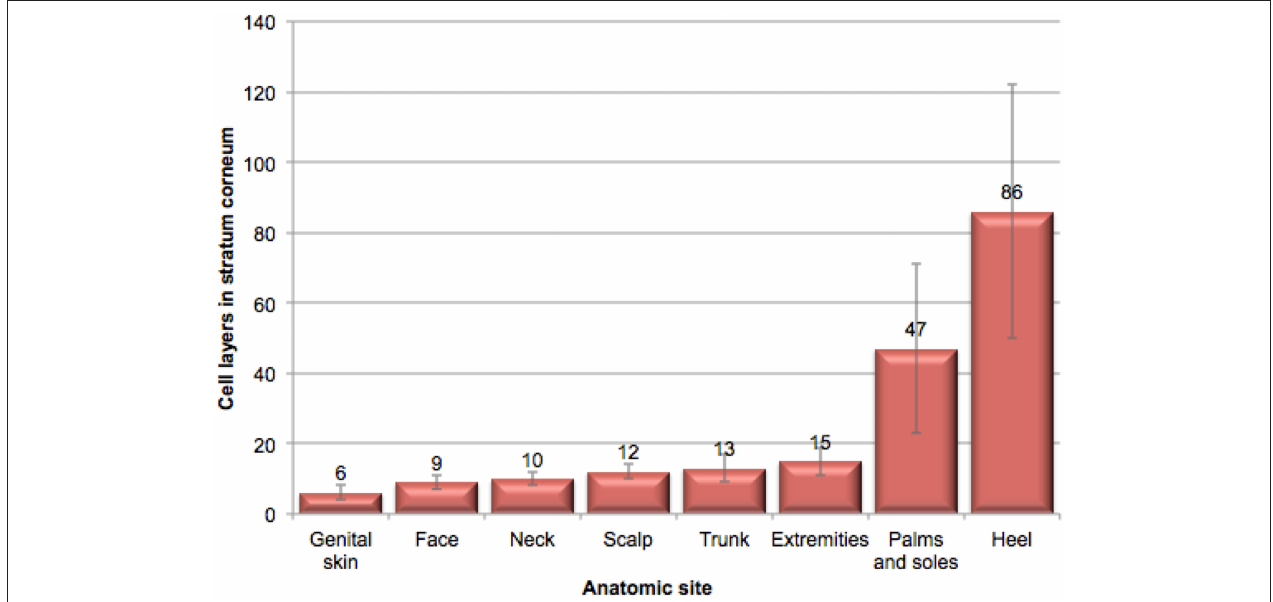
FIGURE 1 | Illustration of stratum corneum thickness at various anatomic sites. This illustration of the relative thickness of stratum corneum at various anatomic sites was adapted from data in Ya-Xian et al. (28).